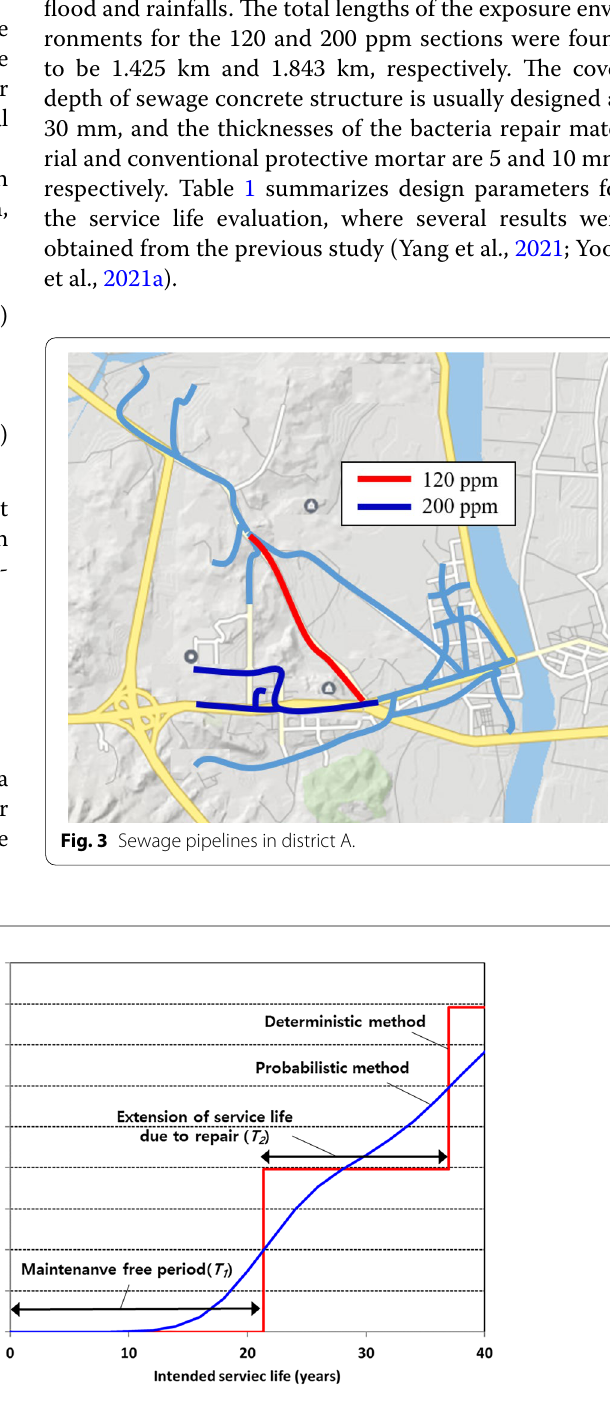
Fig. 2 Conceptual comparison of deterministic and probabilistic repair cost evaluation methods.